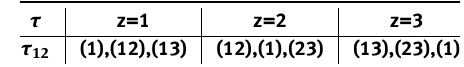
Table 2. Permutation representation of ternary quandle τ 12